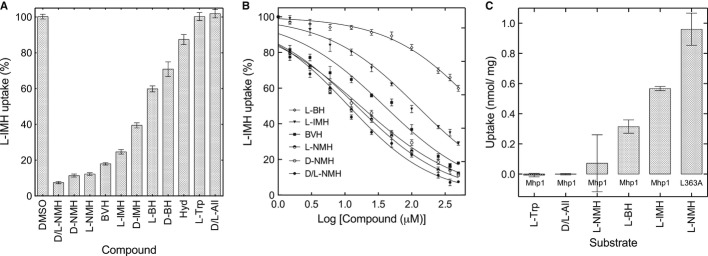
Ligand specificity of Mhp1 determined by uptake assaysA, B Accumulation of 14C-L-IMH (50 μM initial external concentration) into wild-type cells was measured for 15 s (Materials and Methods and Supplementary Methods): (A) in the presence of 500 μM of the indicated unlabelled compound; and (B) dose–response data for 14C-L-IMH uptake in the presence of 0–500 μM of selected unlabelled compound. All measurements were normalised to percentages by comparison with the wild-type value of 0.57 ± 0.01 (s.e.m., n = 34) nmol/mg dry mass, and the error bars represent the s.e.m. of at least triplicate measurements.C Uptakes of the indicated radioisotope-labelled compounds (50 μM initial external concentration, Materials and Methods and Supplementary Methods), into wild-type cells were measured for 15 s for the original Mhp1 protein and for the L363A mutant as indicated at least in triplicate on each of two cell preparations and the s.e.m. calculated for at least six assays. Hyd = hydantoin; All = allantoin. L-tryptophan and D/L allantoin were tested as controls in both (A) and (C).